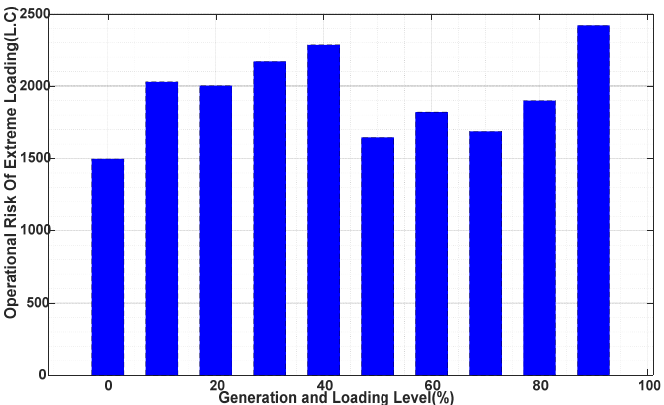
Figure 3. Operational risk of extreme loading as a function of GLL.